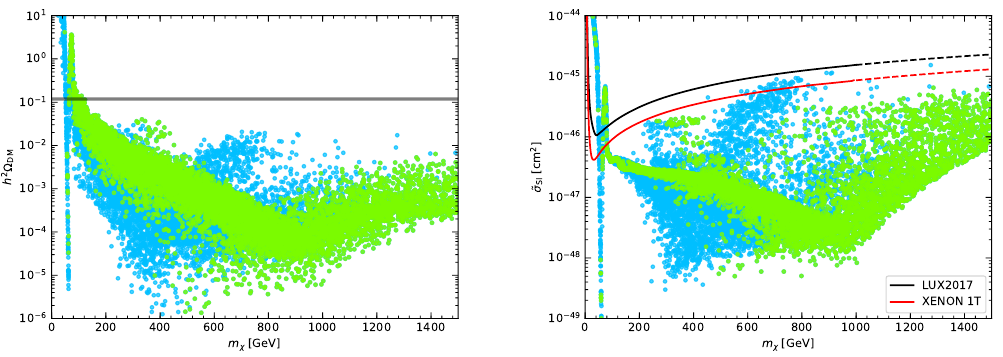
Figure 10 . Left plot: DM thermal relic density as a function of the DM mass. Right plot: e(cid:11)ective spin-independent DM-nucleon elastic scattering cross section as a function of the DM mass. The black and red curves denote the upper limits on scattering cross section from LUX [52] and XENON1T [54] experiments, respectively. In both plots, the blue scatter points represent the samples that have a su(cid:14)ciently strong EWPT and the green scatter points are those further surviving the experimental